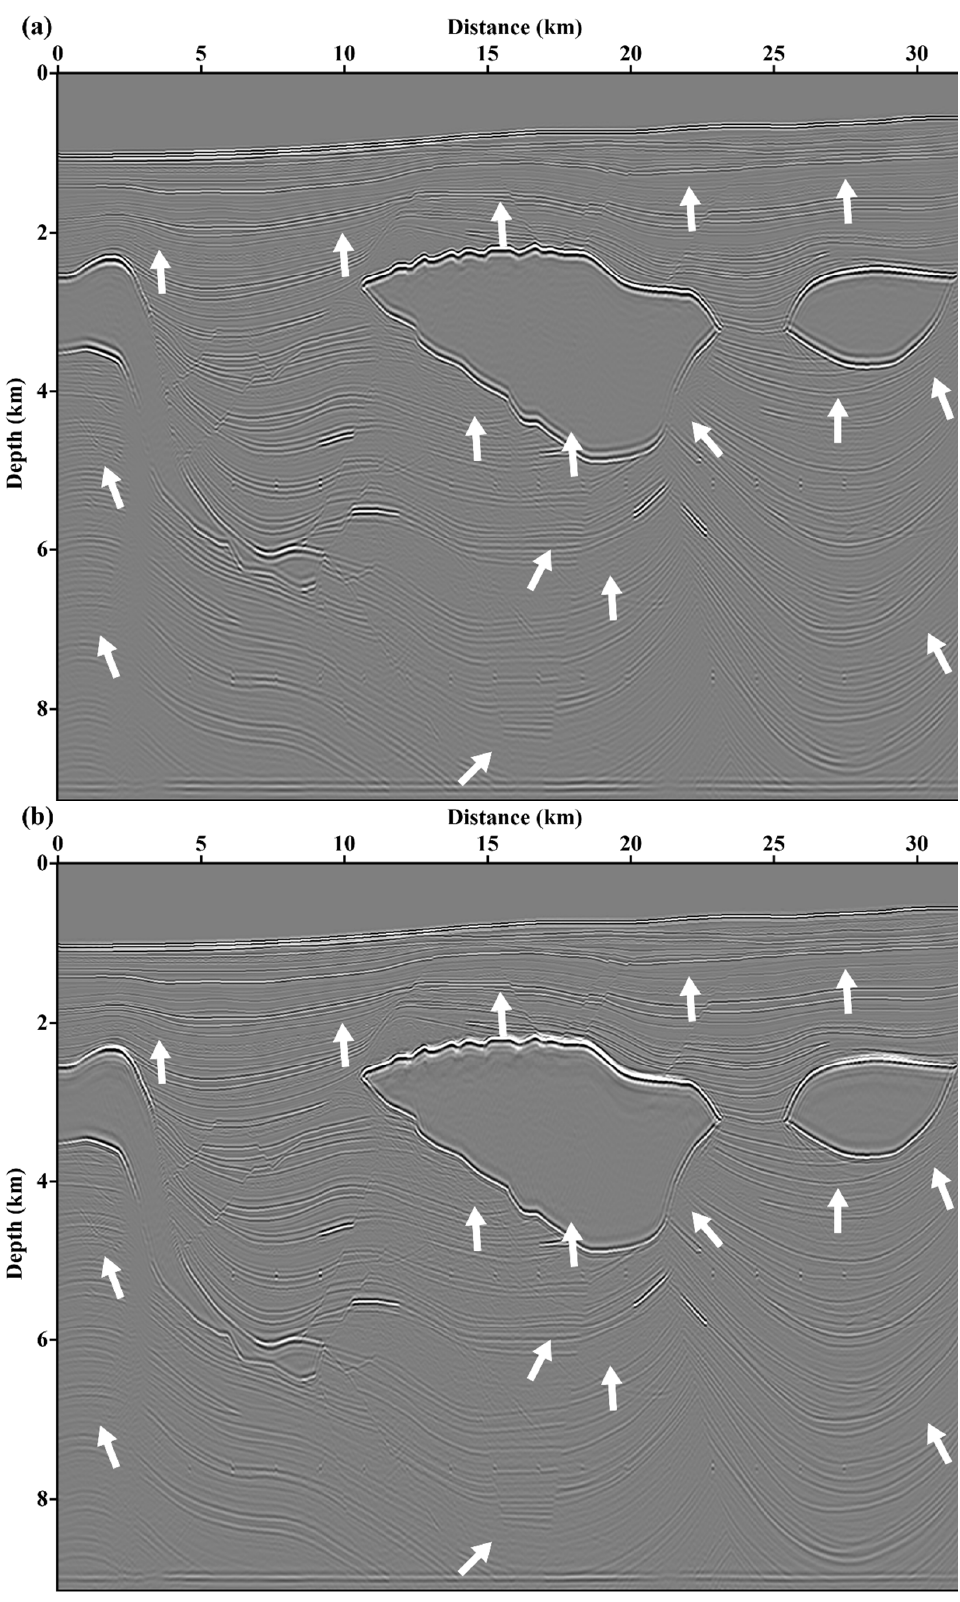
Figure 10. ( a ) The RTM-WM image and ( b ) the LSRTM-WM (six iterations) image.